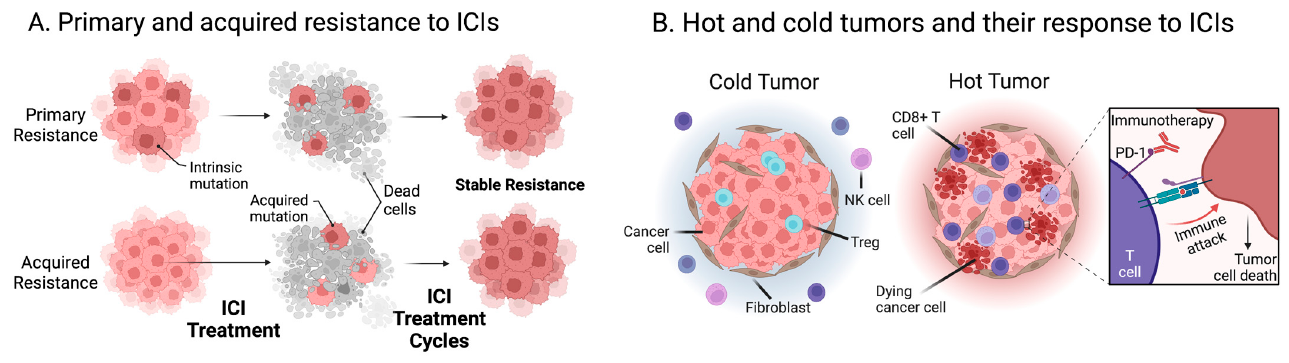
Figure 4. Immunoresistance to ICIs. ( A ) Patients can have primary resistance to ICIs and not respond to treatment at all or can have acquired resistance and undergo a period of initial response to ICIs followed by progression of malignancy and stable resistance. ( B ) Cold tumors have an immunosuppressive TME and show a poor response to immunotherapy, while hot tumors have an immunosupportive TME and are responsive to immunotherapy (Created with BioRender.com; (accessed on 15 January 2023)).